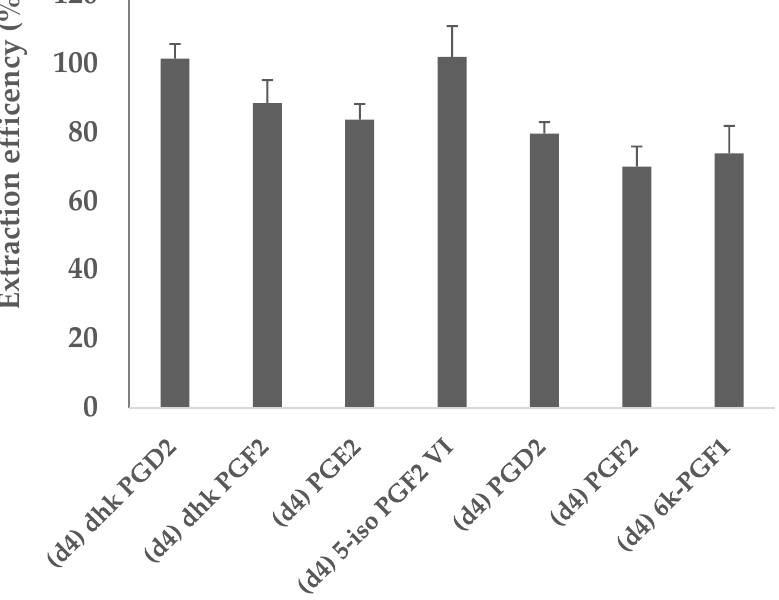
Figure 4. Recoveries of prostaglandin internal standards for the tested MIP-SPE protocol. Deuterated standards were added to the samples before (BE) or after extraction (AE) with MIP, and the extraction efficiency was reported as (Area peak BE/Area peak AE) × 100. The data shown represent the mean recovery percentage ± SD ( n = 3).